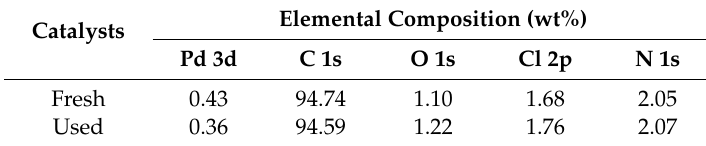
Table 3. Quantified EDS data for the fresh and used Pd-2A-IL / AC